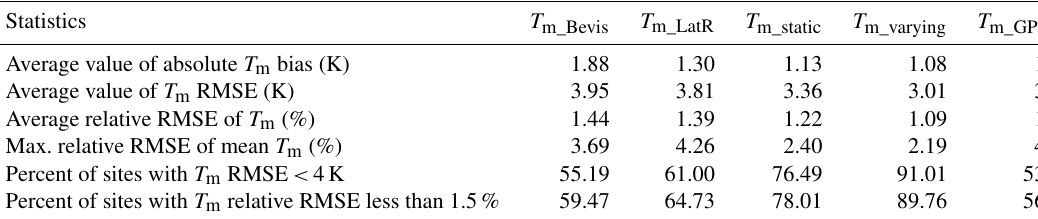
Table 2. Statistics of T m estimates from different models. Reference data are the radiosonde T m derivations. Statistics T m_Bevis